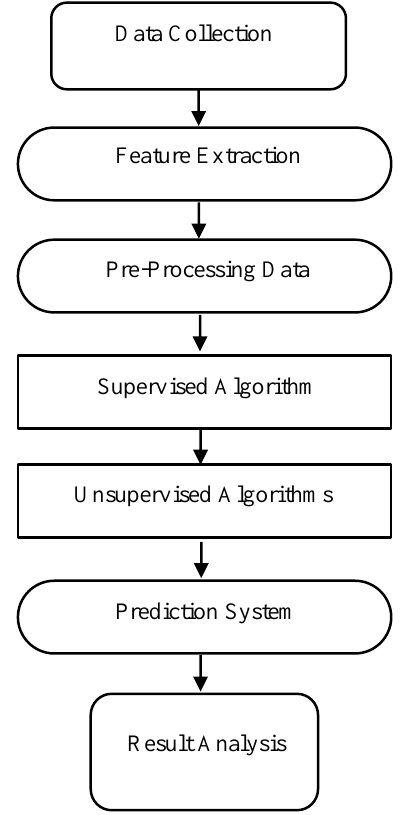
Figure 1. The Flow Chart of The Proposed